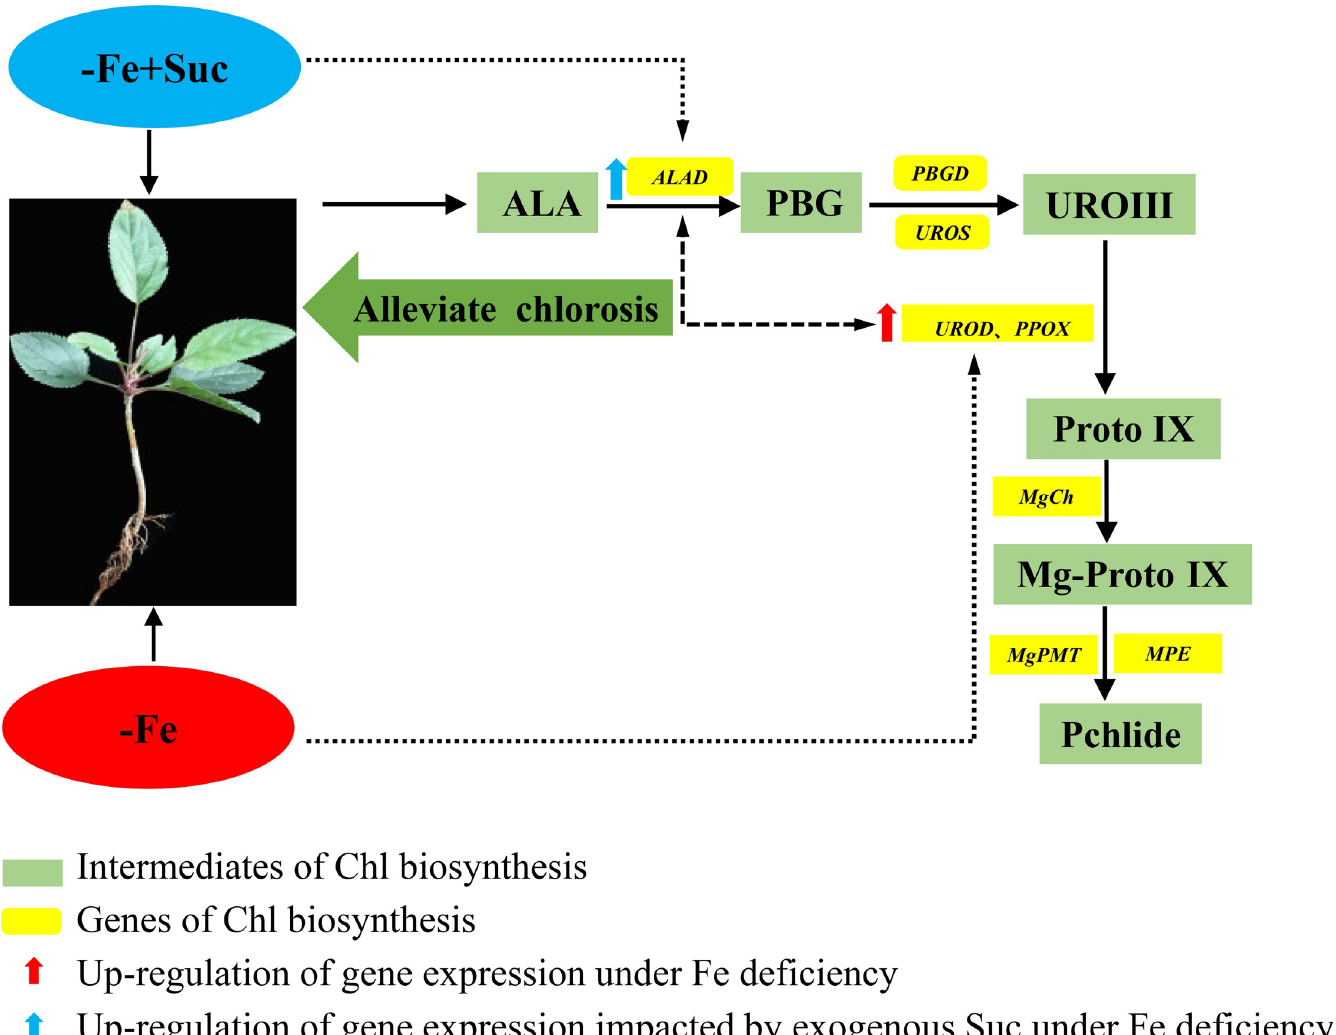
Fig 6. The key synthetic sites of Chl biosynthesis under Fe deficiency and exogenous Suc treatment. Results showed that (1) PPOX expression of M . halliana was enhanced to adapt to Fe-deficient condition. (2) Under Fe deficiency, application of exogenous Suc increased the expression of ALAD and further enhanced Chl